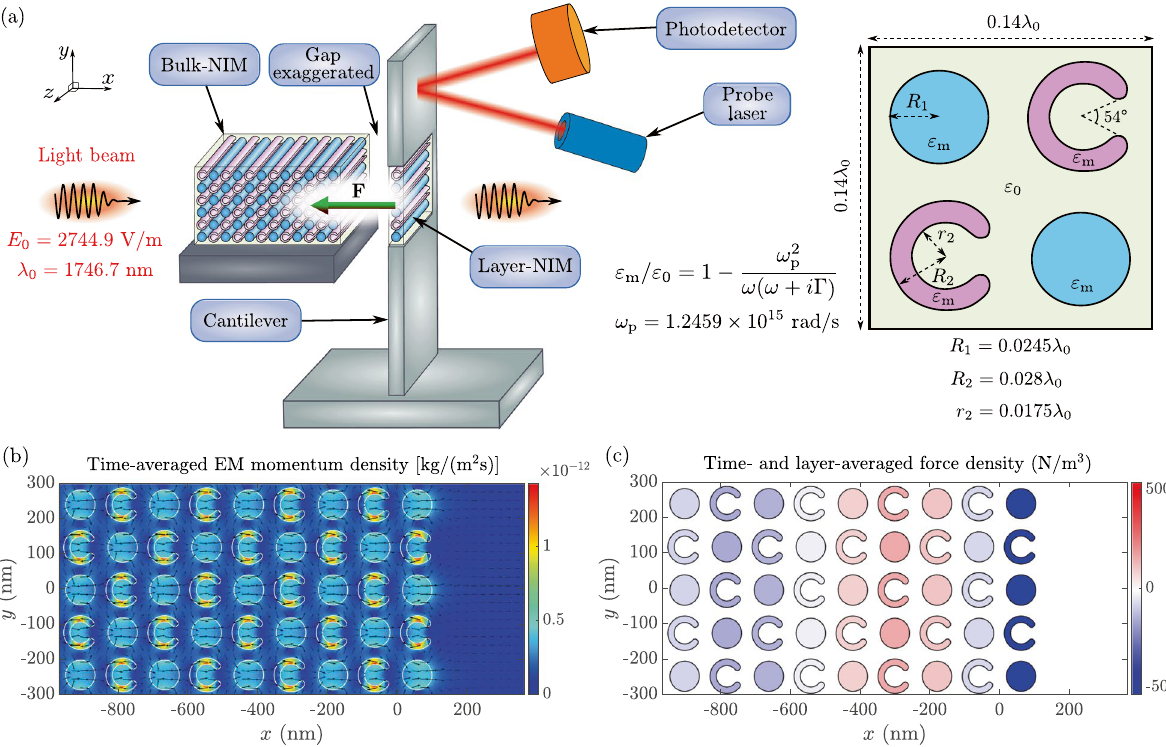
Figure 6. Schematic experimental setup and simulation of reduced or negative radiation pressure. ( a ) Schematic setup for the measurement of the force on the interface where the light beam exits the NIM crystal. The NIM crystal is fabricated on a substrate so that the cylinders and c-shaped rods are fixed from their ends (not shown). The NIM crystal is then split into bulk-NIM and layer-NIM parts. The bulk-NIM is attached to a rigid supporting structure while the layer-NIM is attached to a cantilever. The gap between the bulk- and layer-NIMs is exaggerated to make it visible. In the proposed experiment, this gap is equal to the gaps inside layers of the bulk-NIM. The cantilever is able to bend as a result of the optical force. The nanoscale bending ( ≪ a ) of the cantilever is recorded by monitoring the reflection of a probe laser beam using a photodetector. The right inset shows the NIM structure used in our example. ( b ) Time-averaged EM momentum density of a continuous wave light beam propagating through the NIM. The linearly scaled color indicates the magnitude, and the logarithmically scaled arrows indicate the direction. ( c ) The x component of the total optical force density averaged over the harmonic cycle and over the vertical layers of the NIM. The bulk-NIM is at x < 0 and the layer-NIM is at x > 0